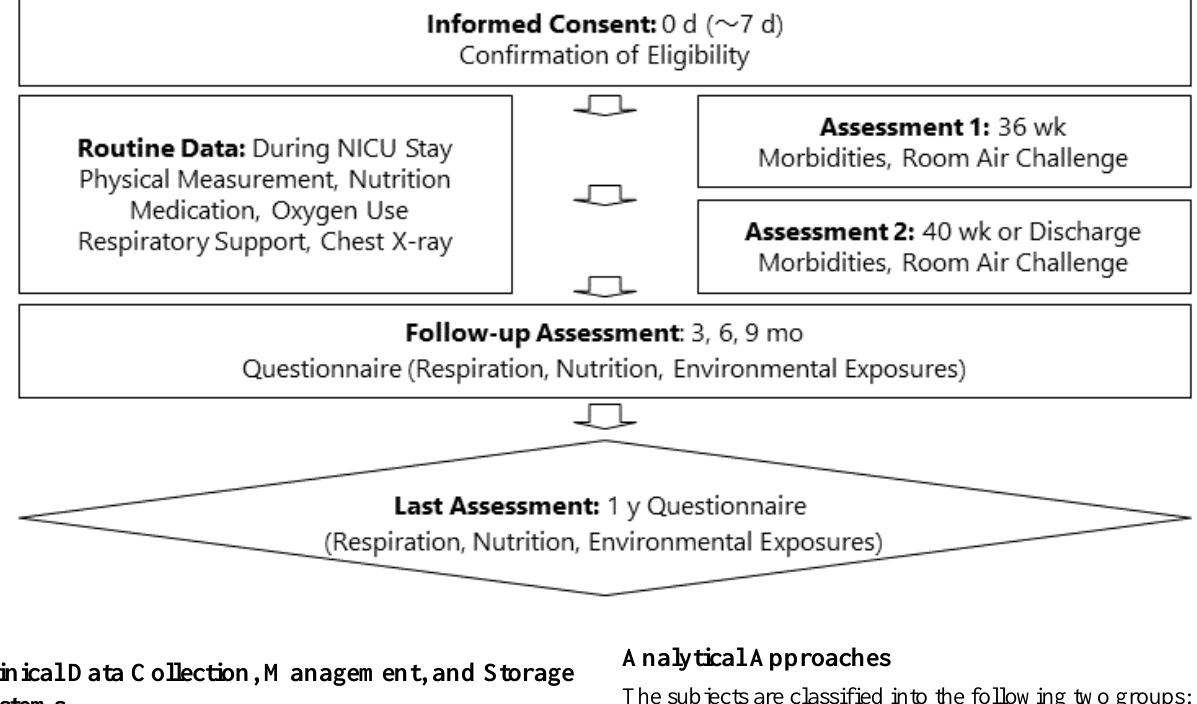
Figure 2. Protocol outline. NICU: neonatal intensive care